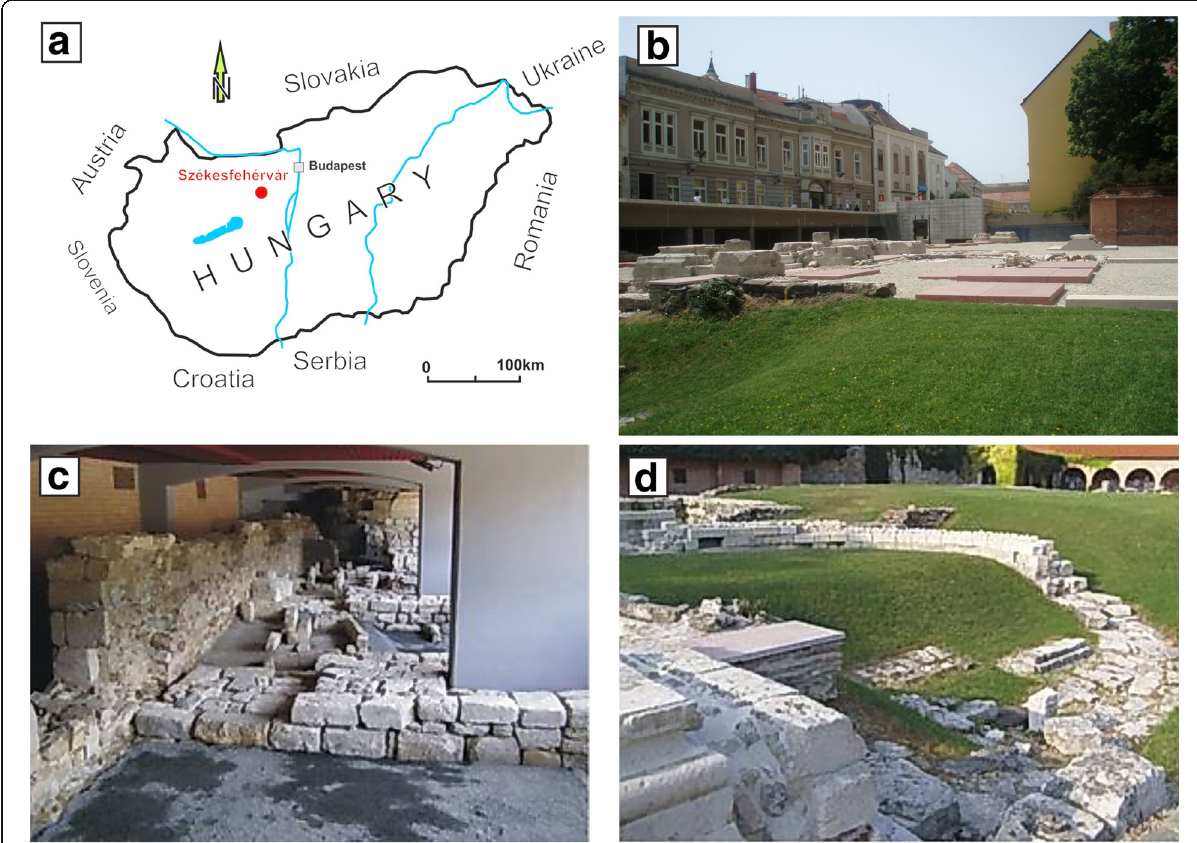
Fig. 1 a Map of Hungary with the location of Székesfehérvár. b – d Different aspects of the Székesfehérvár Ruin Garden, open air and covered